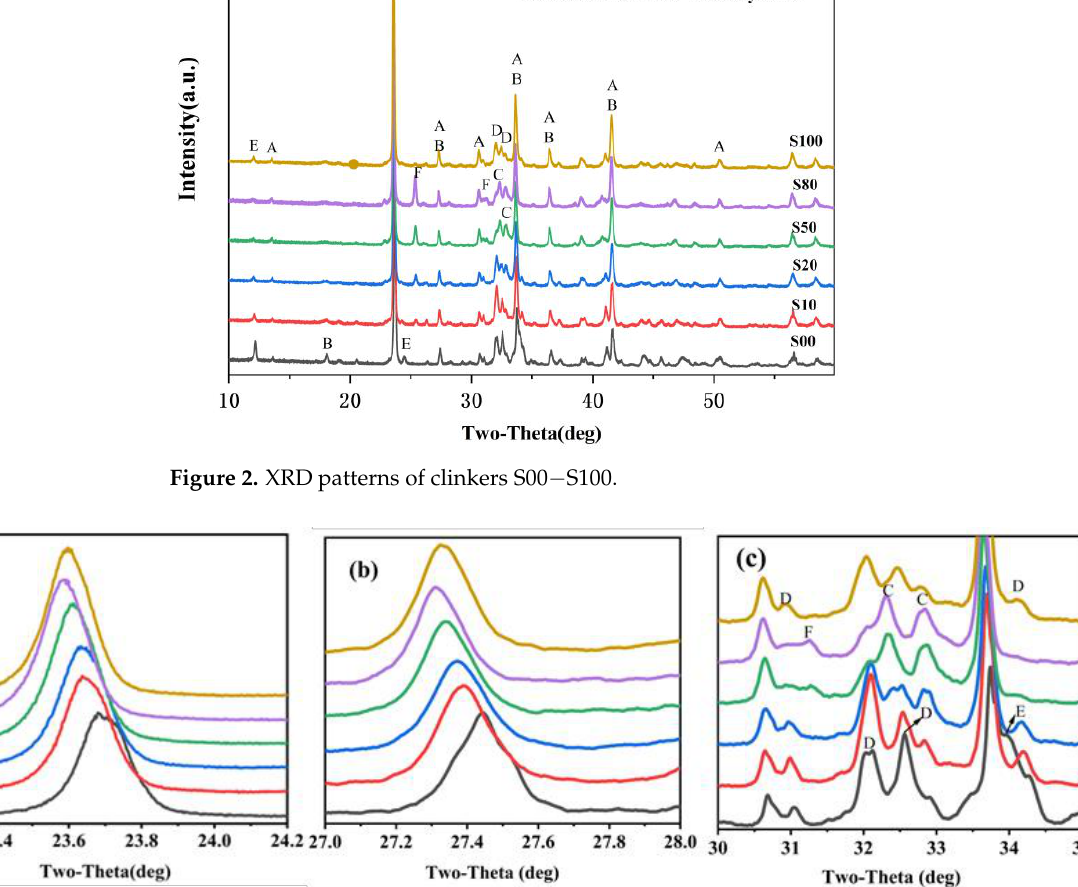
Figure 4. Phase evolution of clinkers S00 − S100. The ferrite phase usually refers to a solid solution with the chemical composition of the formula Ca 2 (Al y Fe 2-y )O 5 , where y can vary from 0 to 4/3 . The ferrite phase, with a chemical composition of y = 0, is specified as srebrodolskite (C 2 F), and the set of assemblages with 0 < y < 4/3 usually have a chemical composition approximating to brownmillerite (C 4 AF) [17]. The formation of brownmillerite is considered to comprise a